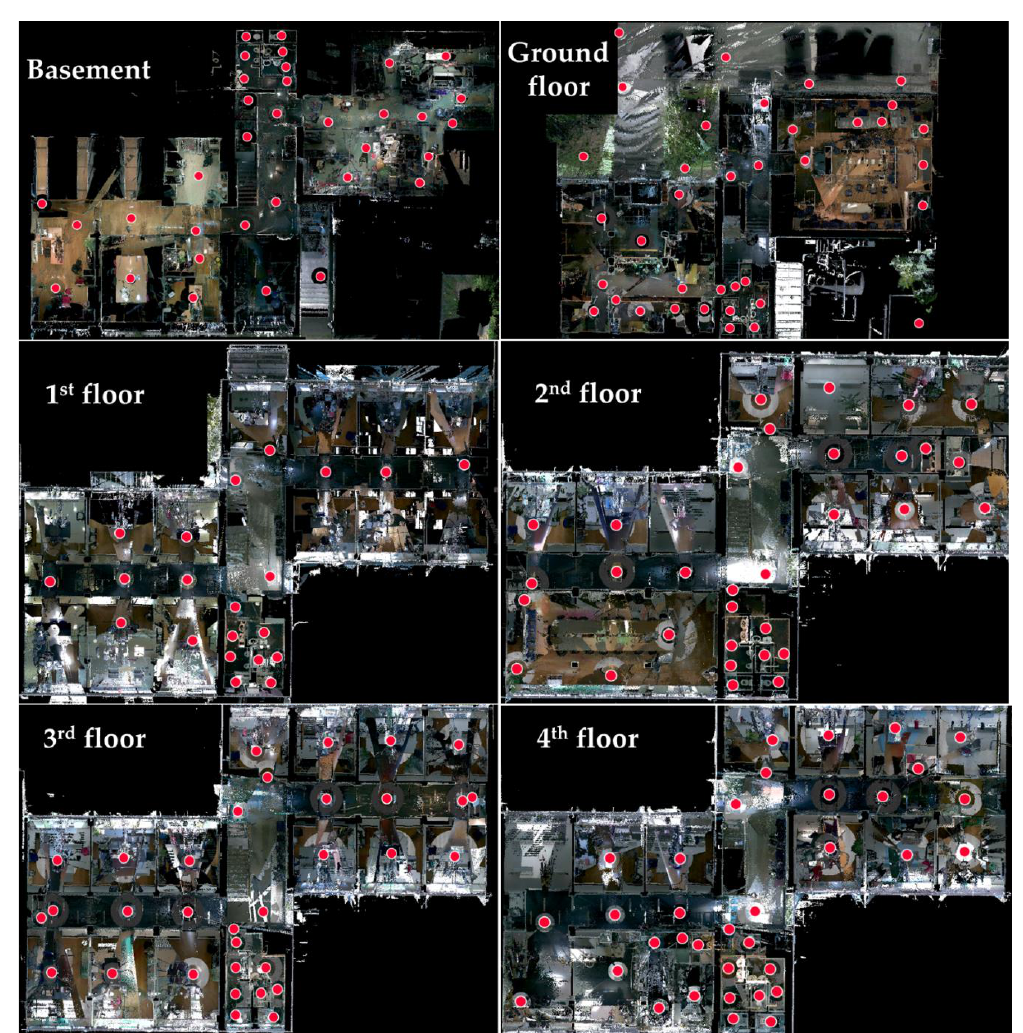
Figure 8. Laser scanning locations by